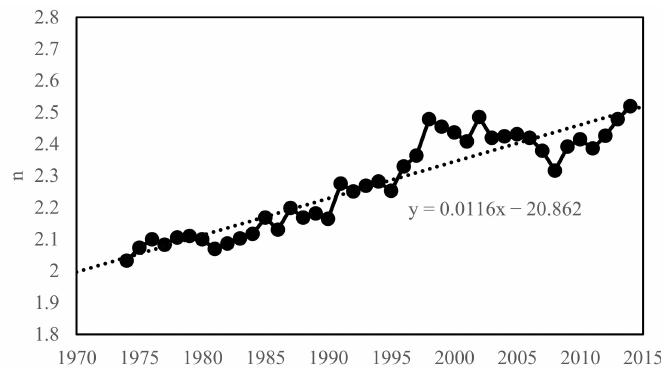
Figure 5. 10-year sliding average n values in the Weihe River